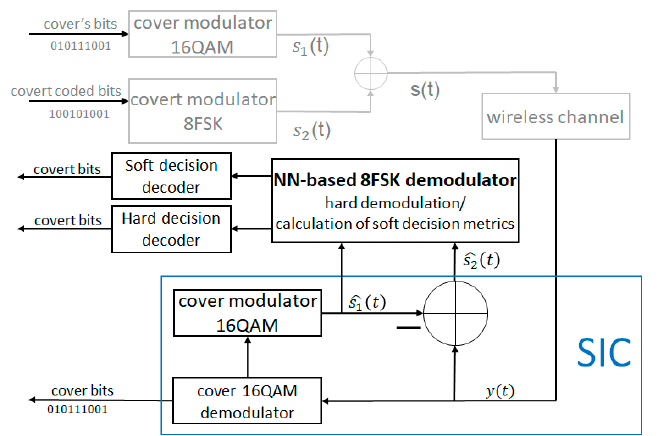
Figure 12. Block diagram of the receiver structure with the NN-based 8FSK hard and soft demodulator.